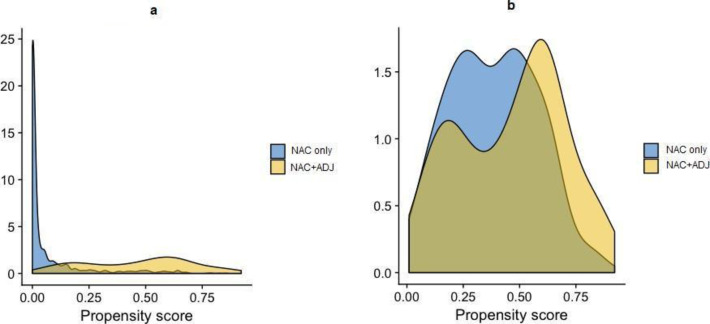
a-b. Propensity score distribution in the NAC only and NAC+ADJ groups, before (Fig 2a) and after (Fig 2b) PS matching.